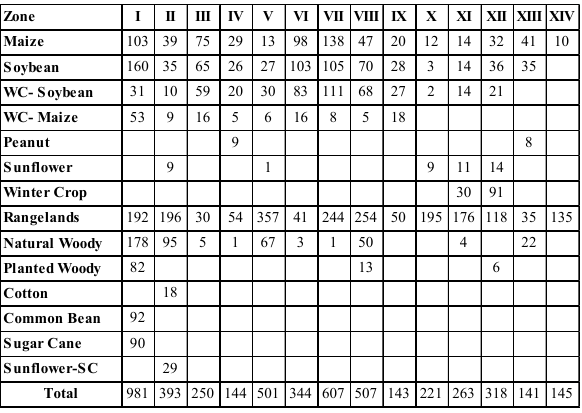
Table 2. Number of samples generated for each class and